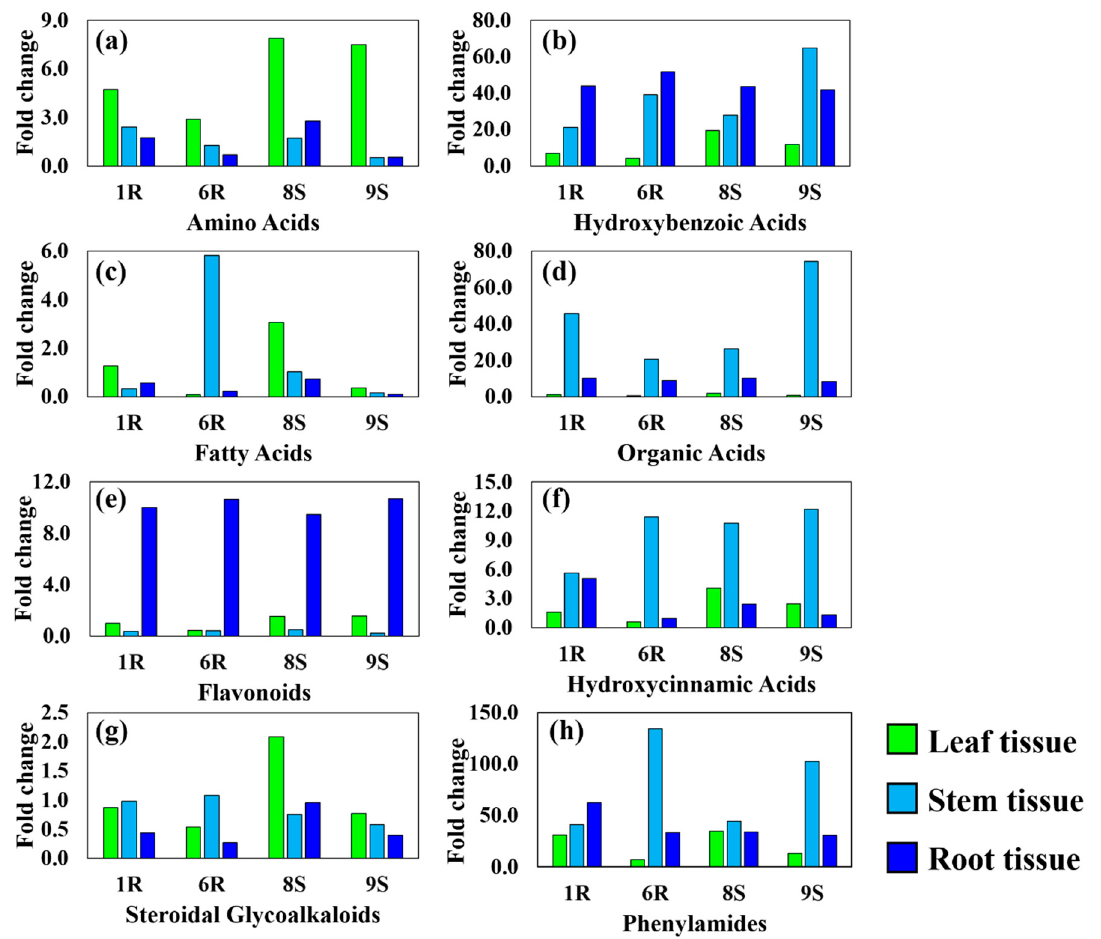
Figure 5. Constructed bar graphs illustrating the respective fold changes of the individual metabolite classes occurring in the leaf (green), stem (cyan) and root (blue) tissues of the four tomato cultivars (1R, 6R, 8S and 9S) after treatment with R. solanacearum, 15 d post infection. The respective metabolite classes presented: ( a ) amino acids, ( b ) hydroxybenzoic acids, ( c ) fatty acids, ( d ) organic acids, ( e ) flavonoids, ( f ) hydroxycinnamic acids, ( g ) steroidal glycoalkaloids, ( h ) hydroxycinnamic acid amides/phenylamides. The calculated fold change of each metabolite (Table S2), in the respective plant tissues, was averaged to display the trend of each metabolite class within each tomato cultivar. Due to the high degree of variability observed as a result of fold change variation of each metabolite no error bars were added to the graphs.